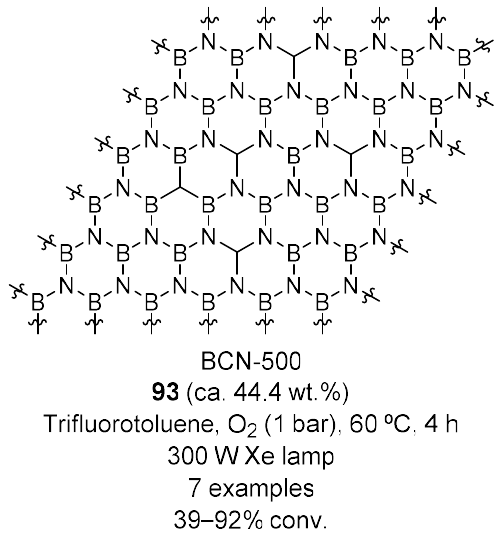
Figure 27. Results obtained in the aerobic photo-oxidation of benzylic alcohols to aldehydes 69 catalyzed by 93 .